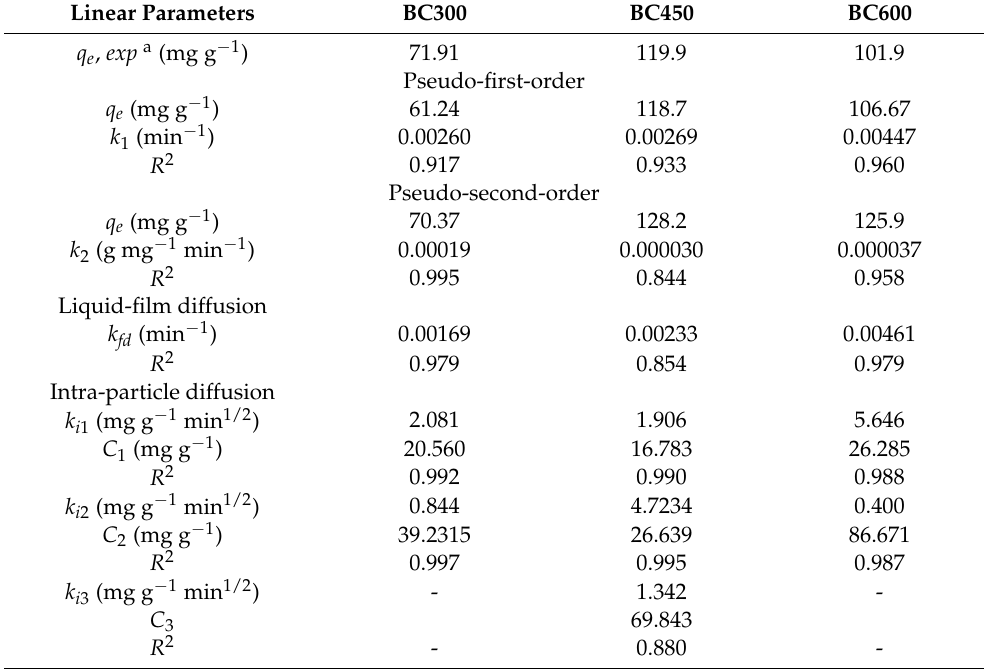
Table 5. Kinetic parameters calculated from the pseudo-first- and pseudo-second-order models, in addition to the intra-particle diffusion and liquid film diffusion linear models. Linear